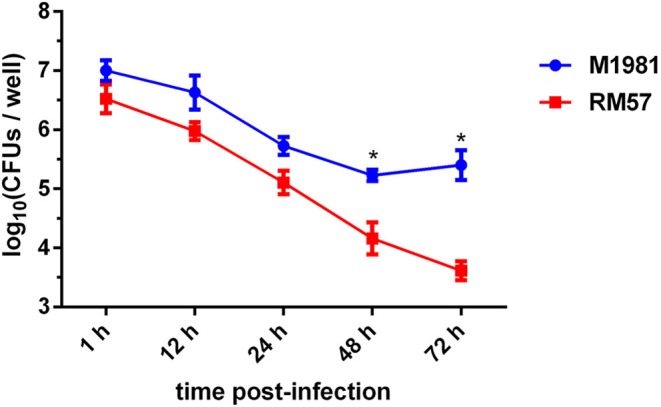
Profiles of virulence attenuation in RM57 in macrophage infection models. Multiplication of RM57 and M1981 strains in RAW264.7 macrophages over 72 h. Values represent the means of three experiments performed in duplicate while error bars indicate the standard deviation (SD) of the mean. *p < 0.05.